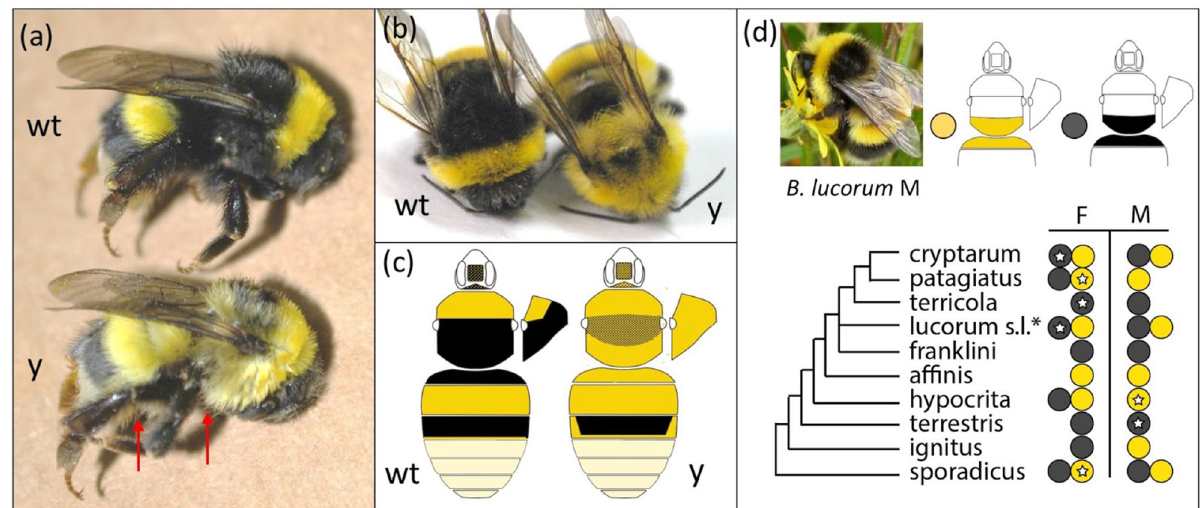
Figure 1. Wildtype (wt) and Yellow (y) mutant color variants of B. terrestris . ( a ) Lateral view of wt and y workers. Red arrows point to yellow leg setae and ventral setae. ( b ) Dorsal view of workers. ( c ) Diagram of coloration pattern differences found in both morphs, showing the pattern for males, which matches the patterns for females. Stipules indicate mixed color. ( d ) The incidence of this phenotype (black vs. yellow patterns on the third thoracic plus first metasomal segment) in the Bombus s.s. clade containing B. terrestris . Some species are polymorphic in this color and species vary in whether this color is sex-specific [male (M), female (F)]. White stars in circles indicate specimens sampled for this study. Intermediates with mixing of setal colors in these segments can sometimes be found. B. lucorum s.l. includes a complex of species, to which color assignment has not been ascribed 31 . The inset photograph (cropped from Ref. 92 , creative commons license) depicts a yellow B. lucorum male morph from Scotland, which displays the same color pattern as the mutant B. terrestris phenotype. Phylogeny based on Ref. 93